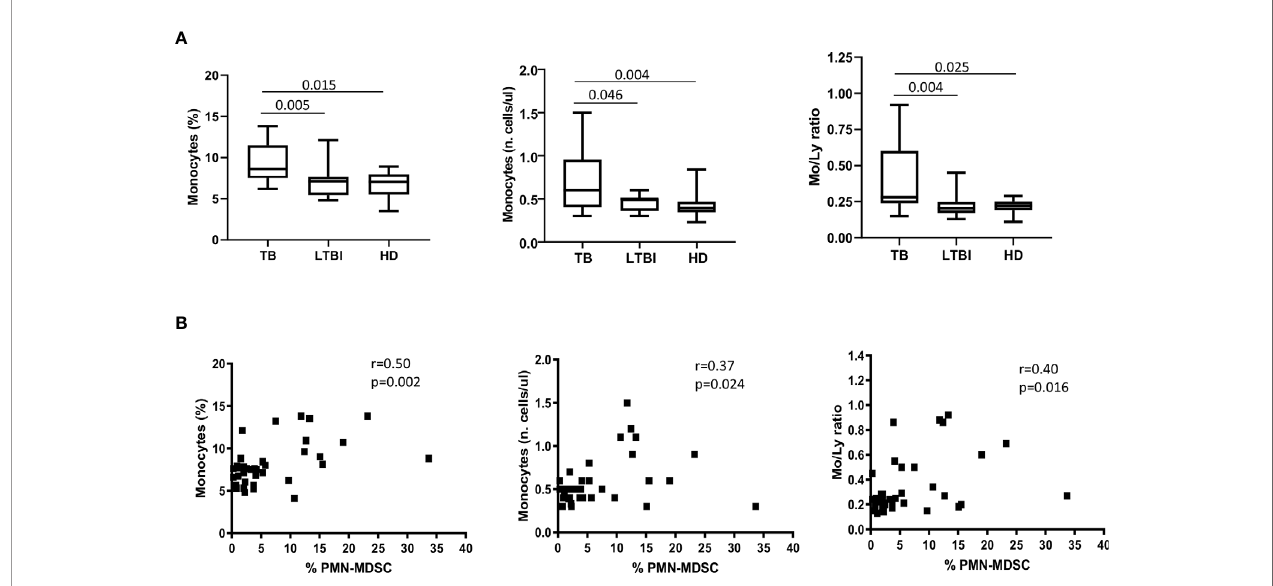
FIGURE 2 | PMN-MDSC correlates with monocyte percentage and number, and with Mo/Ly ratio. (A) The monocytes percentage and absolute number, and Mo/Ly ration in active TB (18), LTBI (19), and HD (12). Results are shown as Box and Whiskers. The Kruskall-Wallis test (with Dunn ’ s multiple comparison posttest) was applied. (B) Correlation between PMN-MDSC frequency and percentage and number of monocytes, and with Mo/Ly ratio from TB (18) and LTBI (19) individuals. The Spearman test was applied to evaluate correlations. The p <0.05 was considered statistically signi fi cant. TB, tuberculosis; LTBI, latent tuberculosis infection; HD, healthy